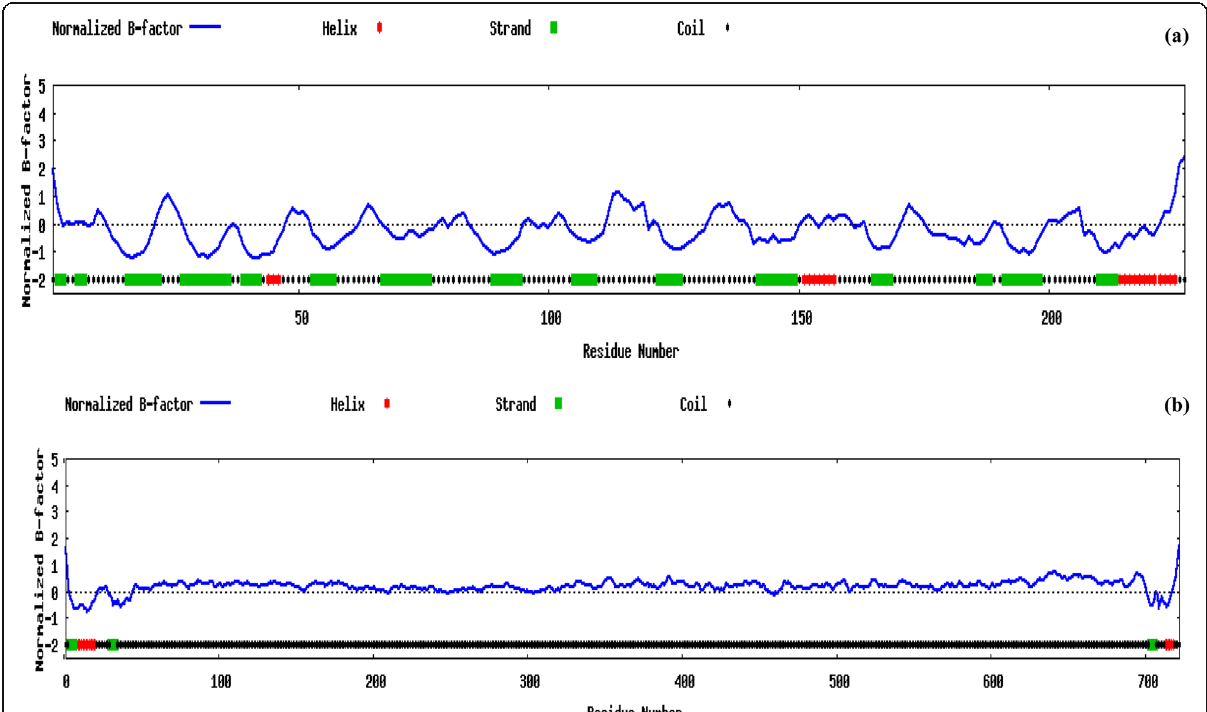
Fig. 8 The predicted normalized B-factor by ResQ, showing the estimated global and local accuracy. The regions at the N- and C-terminals and most of the loop regions are predicted with positive normalized B-factors, indicating that these regions are structurally more flexible than other regions. a The predicted normalized B-factors of cocoonase for the α and β regions are negative or close to zero, suggesting that these regions are structurally more stable. b On the other hand, the predicted normalized B-factors of sericin for the alpha and beta regions are close to zero, suggesting these regions are structurally less